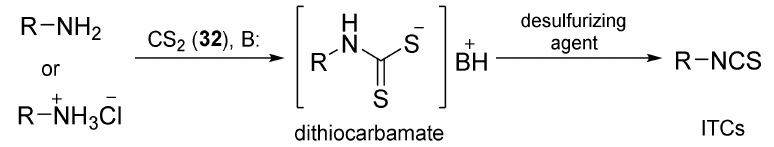
Figure 11. Synthesis of isothiocyanates using a desulfurizing